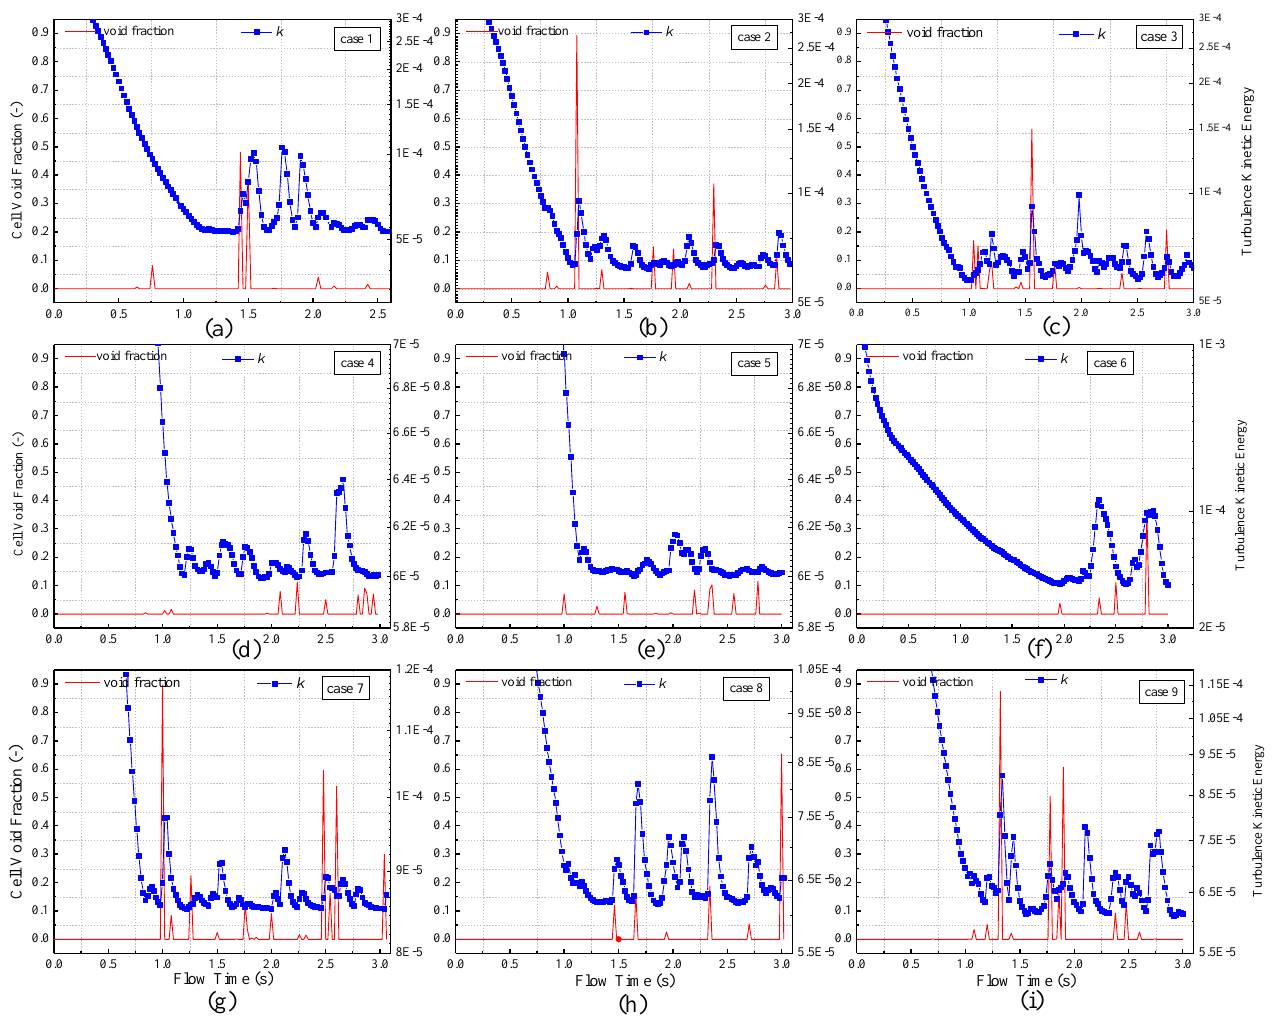
Figure 11. Bubble effect on turbulence kinetic energy under different dispersed bubble flow conditions (Cases 1 – 9), seen in Table 1.